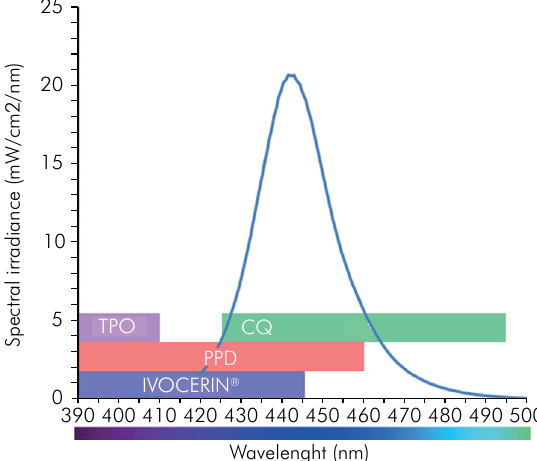
Figure 27. Spectral emission from a typical second generation, blue LED curing light.